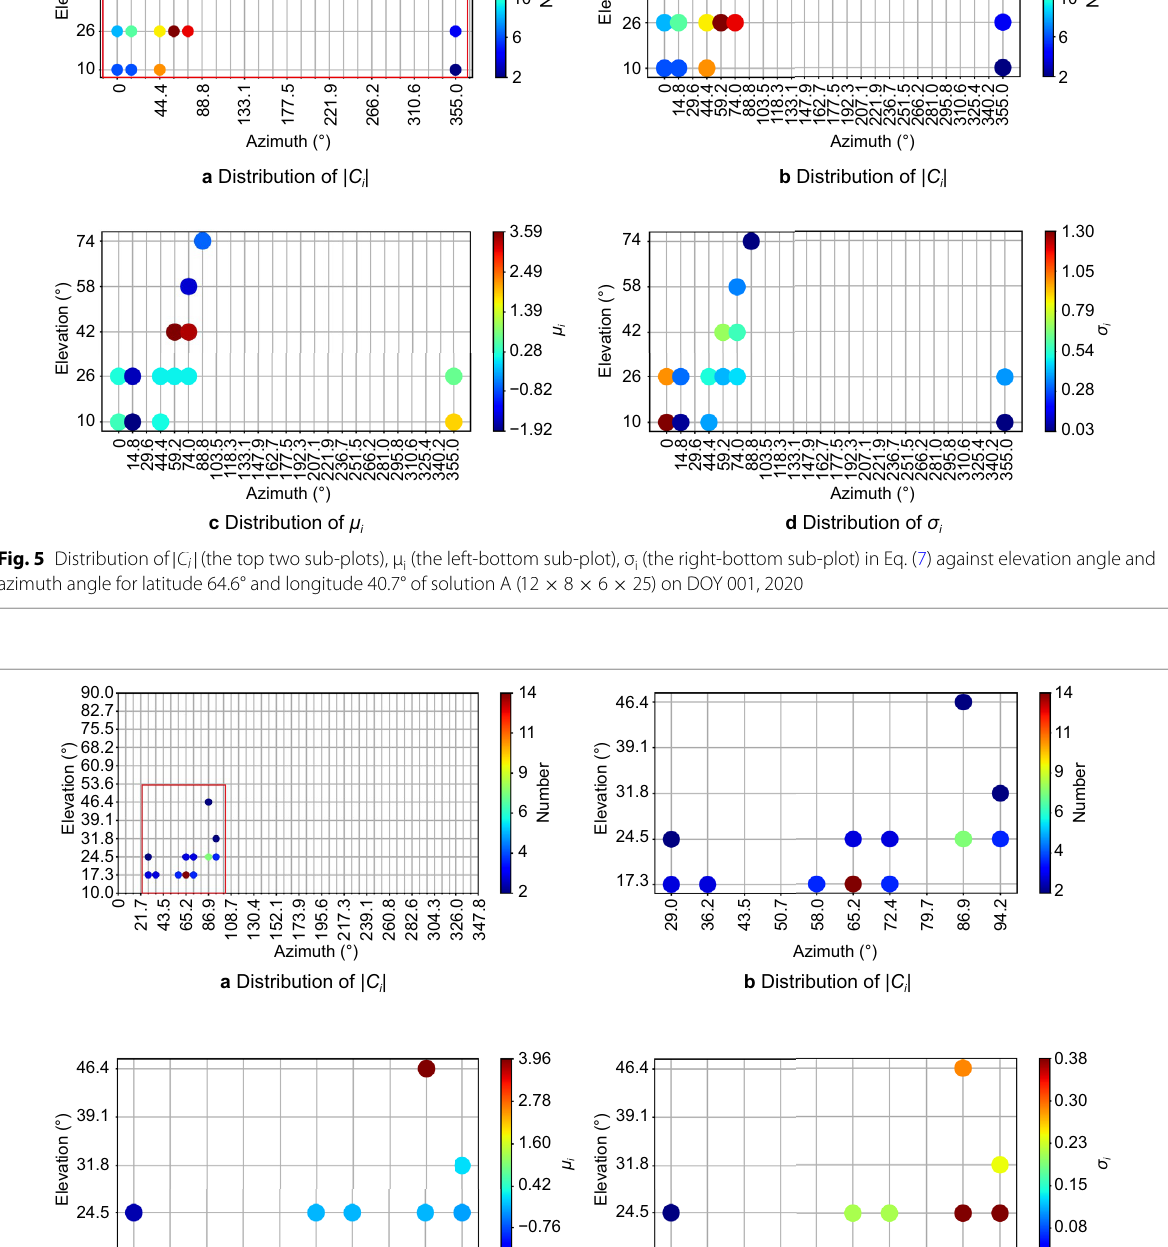
a Distribution of | C i |